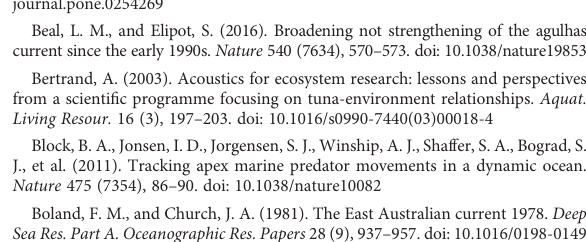
SUPPLEMENTARY FIGURE 1 Spatial distribution of acoustically derived biological aggregation metrics calculated for the area surrounding transect stations overlaid over sea surface temperature (IMOS MODIS SST) for all surveys with point size representing: (A) themeandepth ofaggregations; (B) thepercentagearea around the station containing biological aggregations; and (C) the mean aggregation